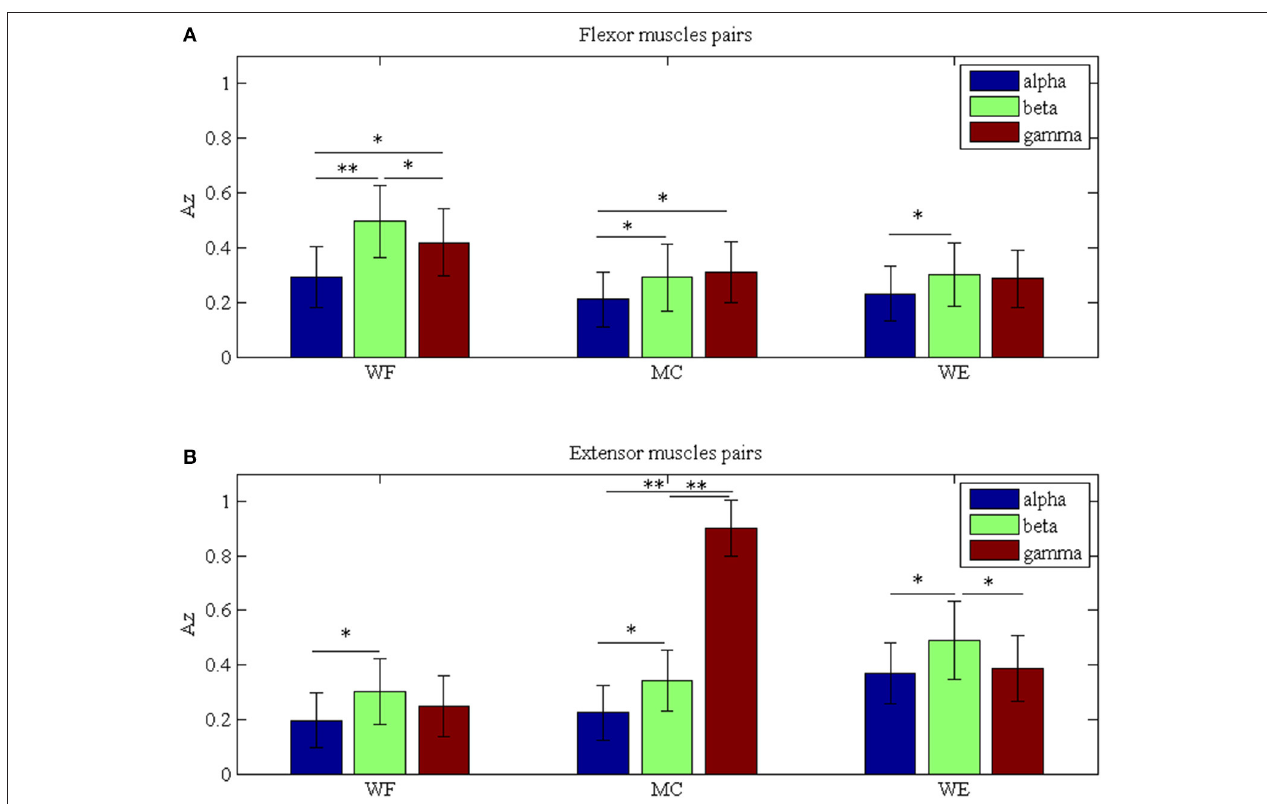
FIGURE 7 | Grand averages of the A z values in the three stages for (A) Flexor muscle pairs and (B) Extensor muscle pairs in the alpha, beta and gamma bands, respectively. We denoted the significance with the star mark. * p < 0.05 and ** p <